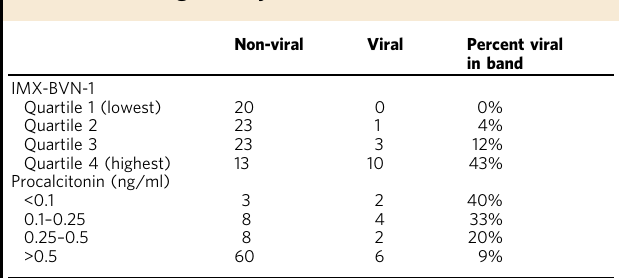
Table 4 Viral diagnosis by